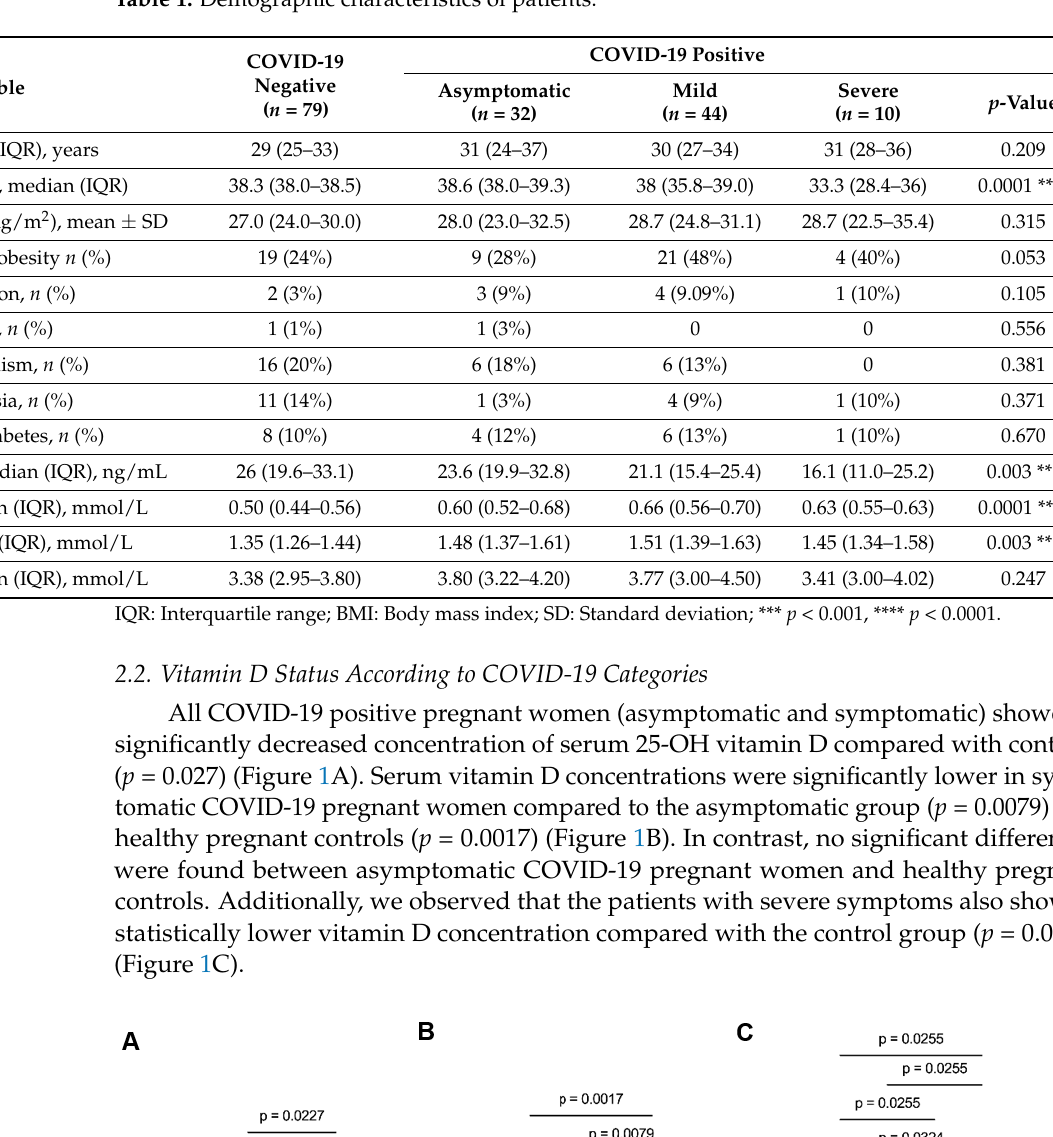
Table 1. Demographic characteristics of patients.